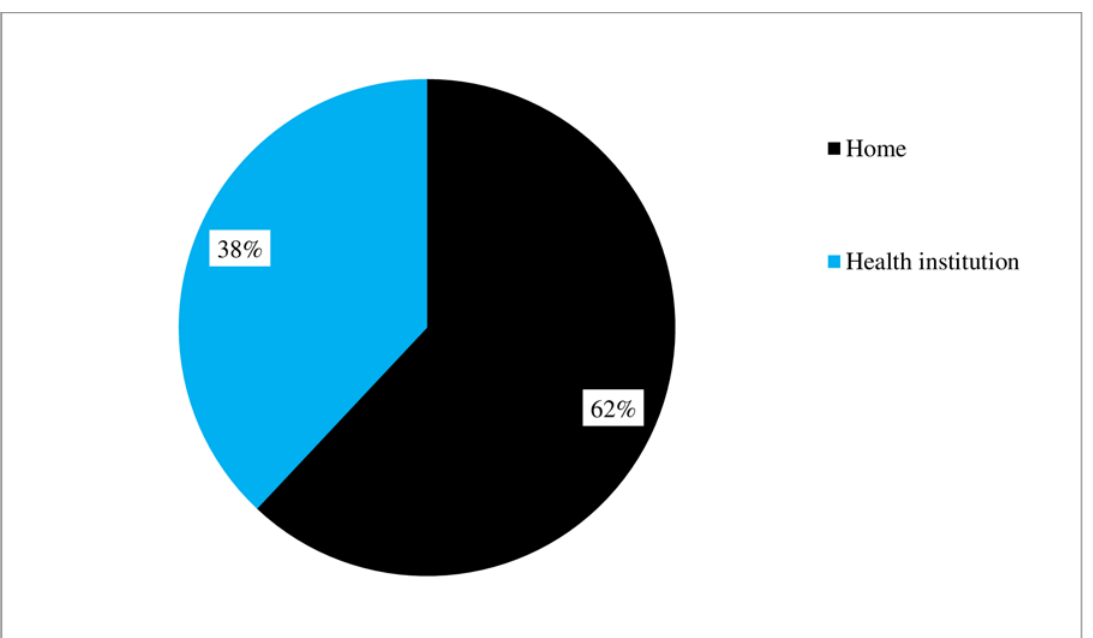
Fig 1. Place of delivery of index child, assessment of institutional delivery service utilization in Wolaita and Dawro zone,